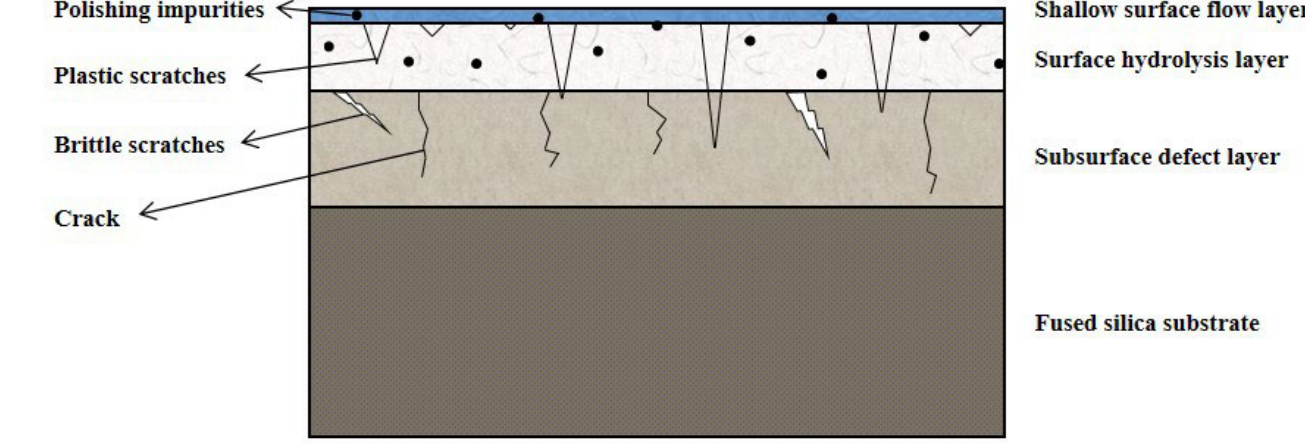
Figure 4. Subsurface damage model for quartz glass after chemical mechanical polishing.